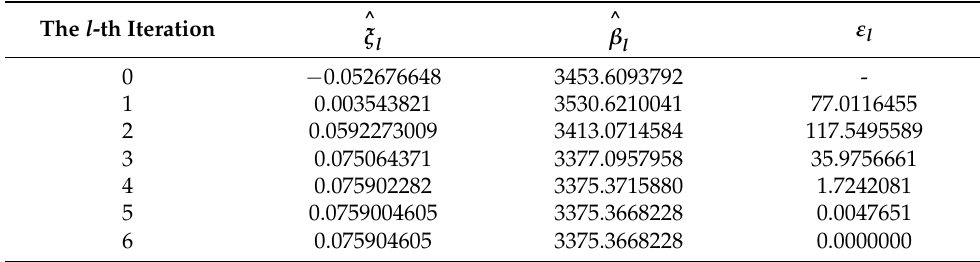
Table 3. The Newton–Raphson iteration for houses